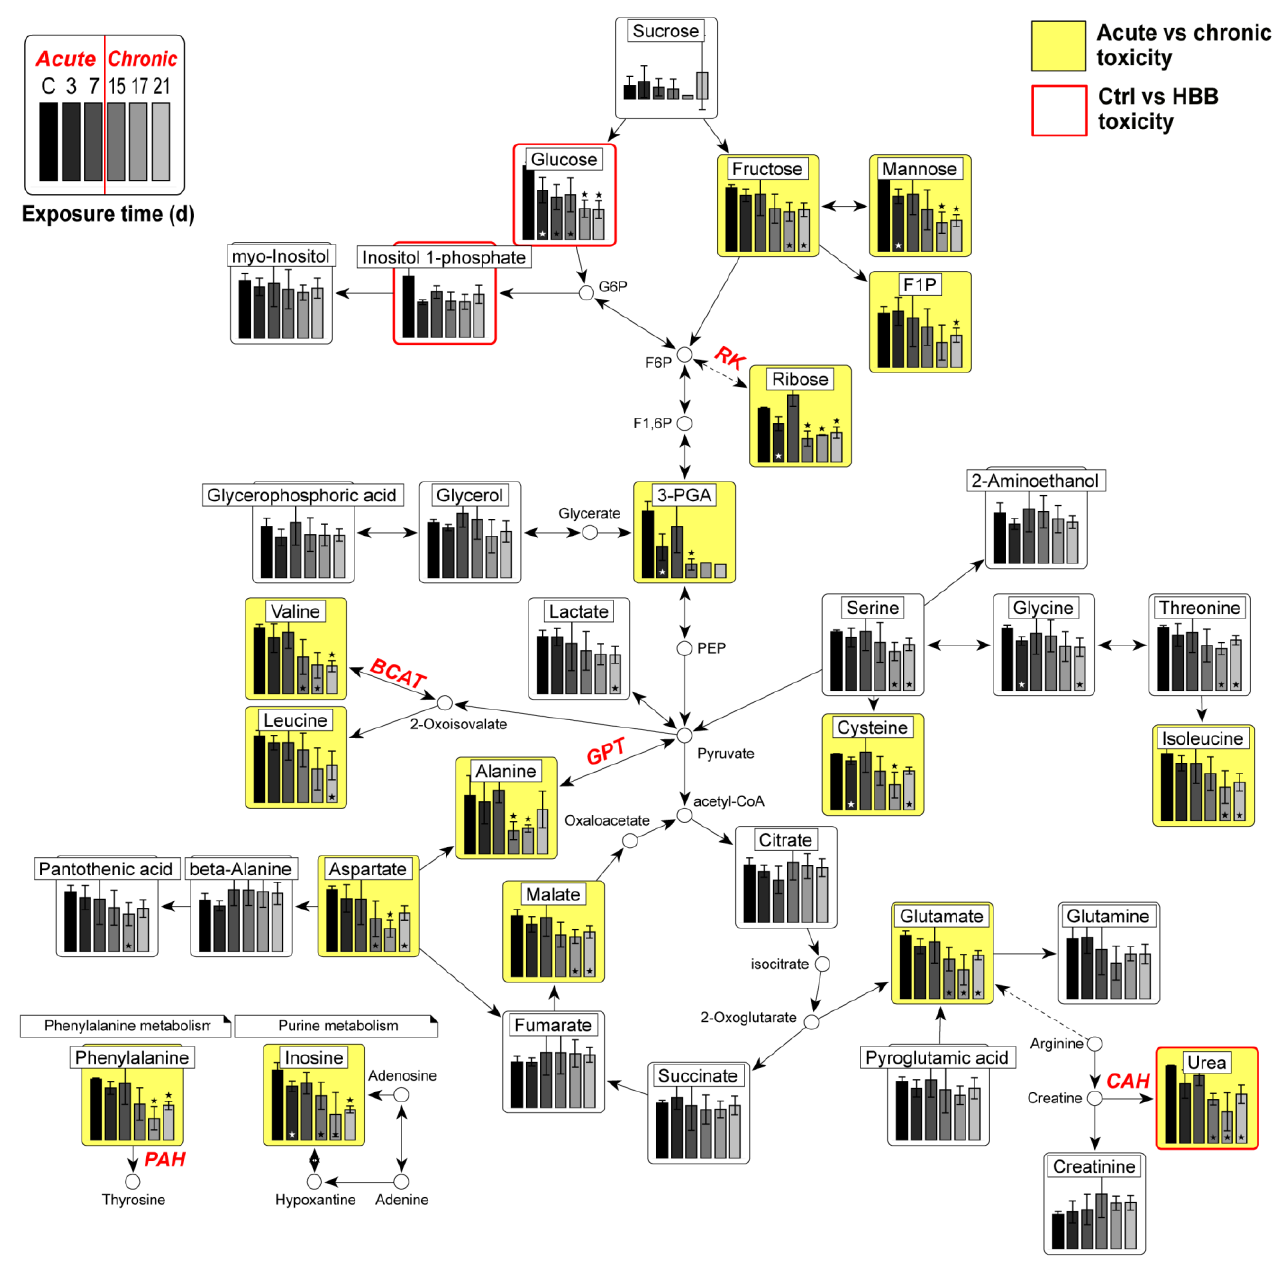
Figure 4. Metabolic pathway networks with a bar plot of 35 metabolites. The proposed metabolic pathway is presented based on the KEGG database. The x -axis represents the control group and HBB exposure days, and the y -axis represents the normalized abundance. Significant differences are indicated by t -test results (* p < 0.05). Red borders indicate significant metabolites comparison of control/HBB-exposed groups. Yellow boxes indicate the metabolites that are significant in the acute versus chronic statistical analysis. Five enzymes, i.e., GPT, PAH, RK, CAH, and BCAT, which are used for molecular docking, are indicated on the pathway (Abbreviations: 3-PGA, 3-phosphoglyceric acid; F1P, fructose 1-phosphate; PEP, phosphoenolpyruvate; F1,6P, fructose 1,6-bisphosphate; F6P, fructose 6-phosphate; G6P, glucose 6-phoshpate).